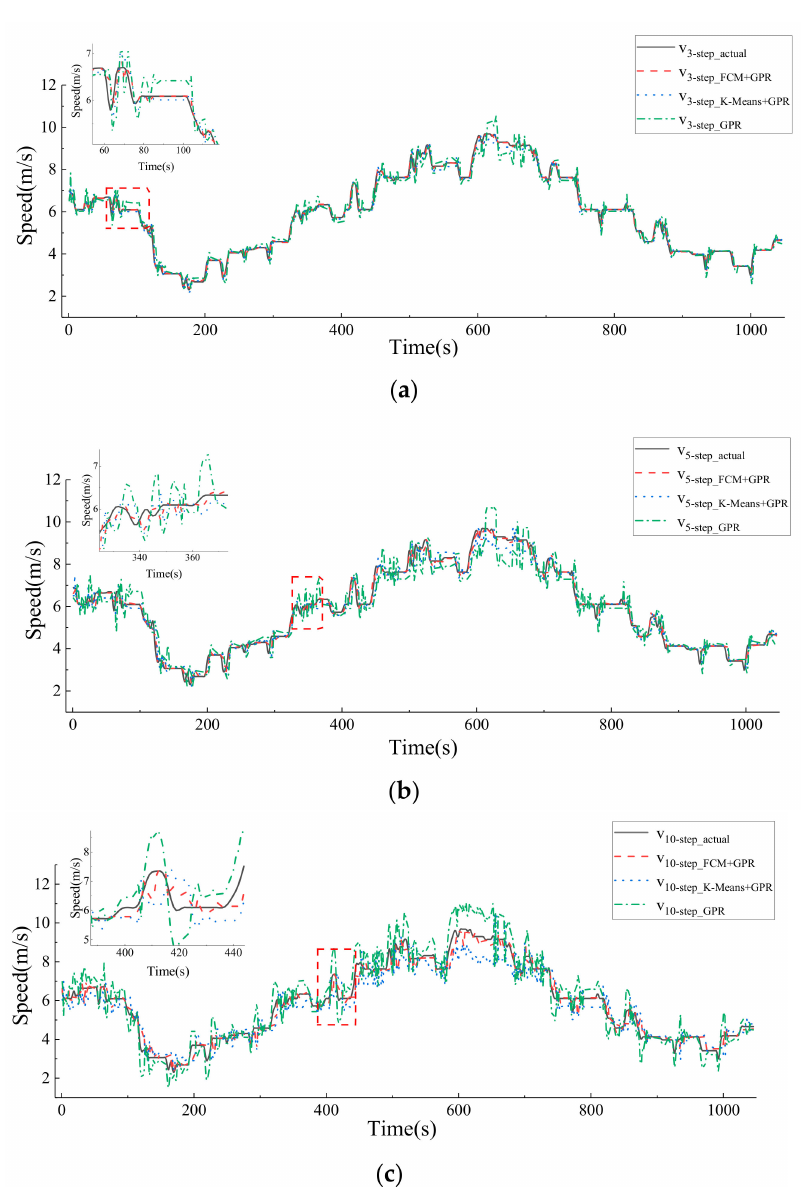
Figure 3. Comparison of multistep velocity prediction results: ( a ) comparison of the results of 3-step speed prediction; ( b ) comparison of the results of 5-step speed prediction; ( c ) comparison of the results of 10-step speed